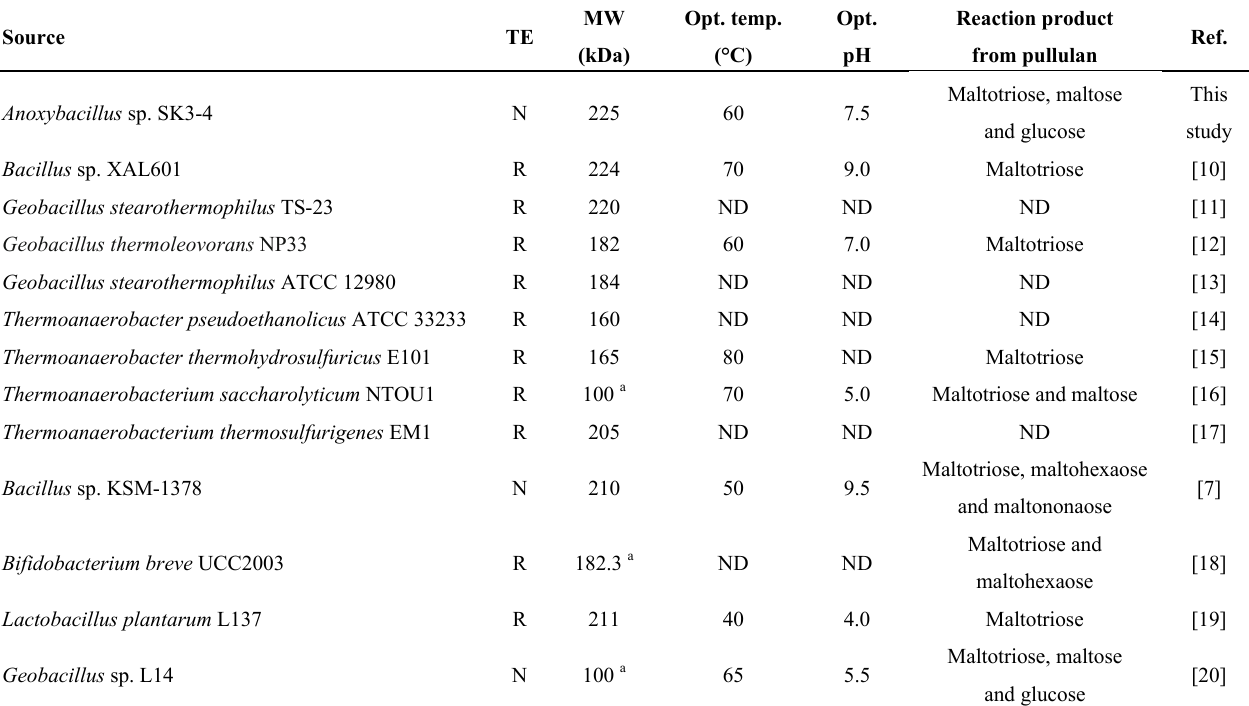
Table 1. Source and biochemical properties of several known